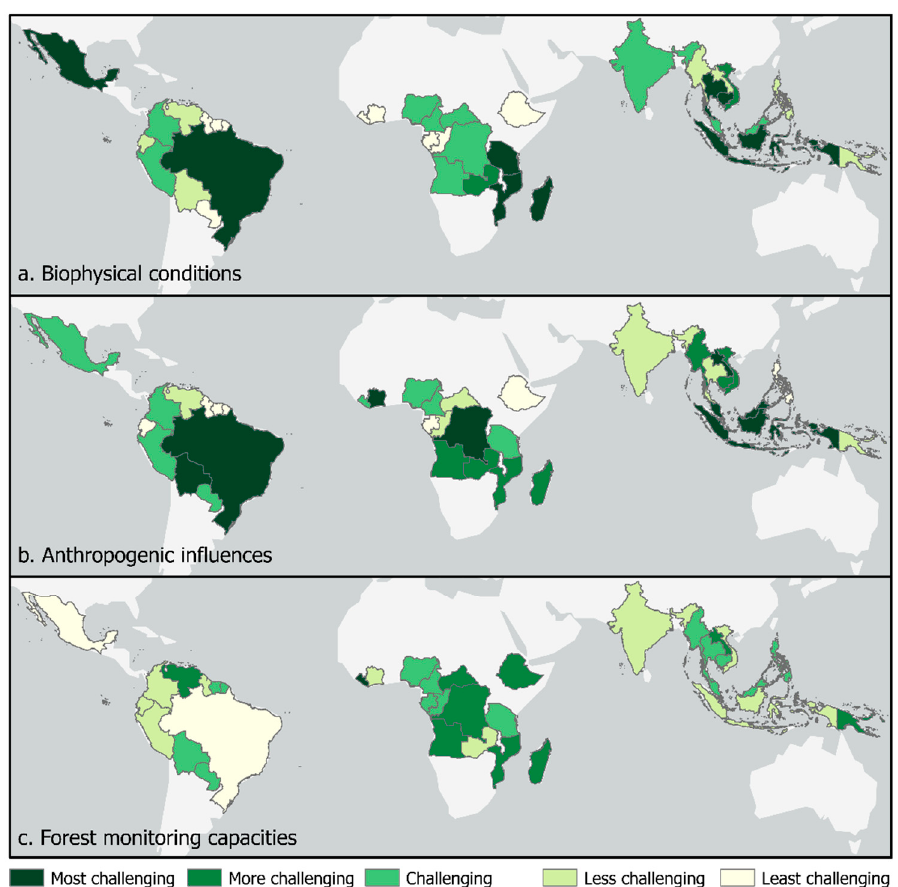
Figure 1. Classification of the countries regarding their biophysical conditions, anthropogenic in- fluences, and forest monitoring